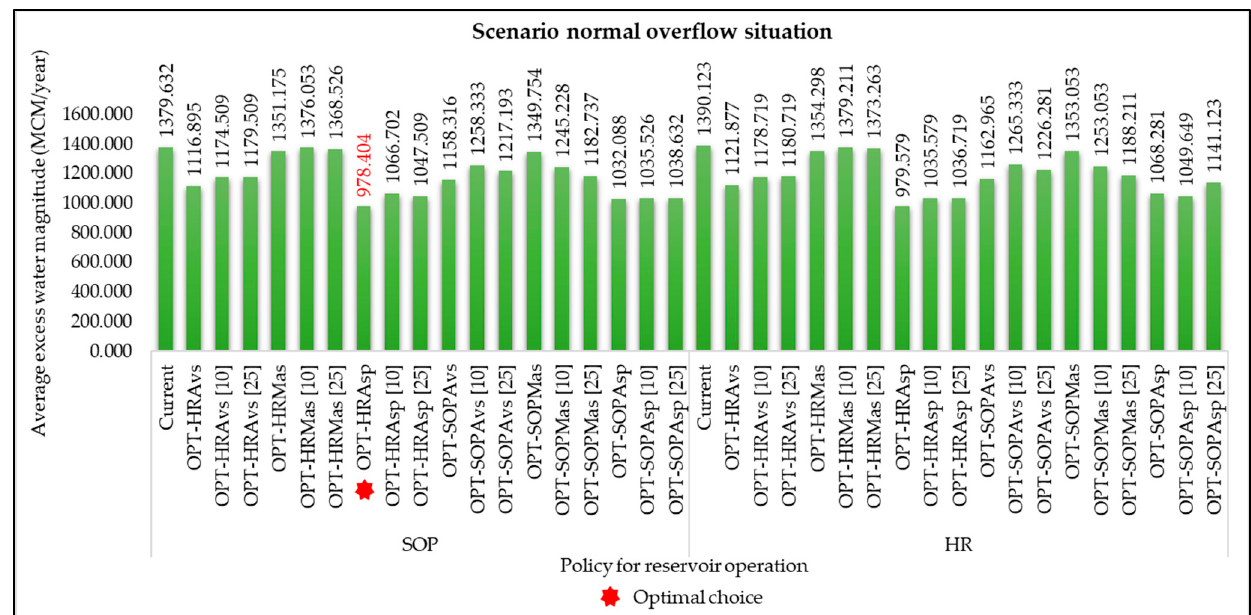
11 of 17 Figure 9. Optimal choice for operating rule curves under serious effect of high water shortage situation. 3.1.3. Scenario of Normal Overflow Figure 10 illustrates the average excess water for each rule curve. The figure also shows that when the network reservoir experienced an overflow problem, it was merely a normal overflow that did not have a serious impact. The rule curve that the reservoir should choose to apply is the rule curve with the objective aim of obtaining the minimal average excess water per year with the HR criterion (OPT-HRAsp). In this case, the decision maker must use the established rule curves for releasing water with the SOP release threshold, which will result in a mean minimum overflow of 978.404 MCM/year. Obviously, the results also demonstrated that using the HR water discharge criteria to find the rule curves in conjunction with the appropriate objective function is not only